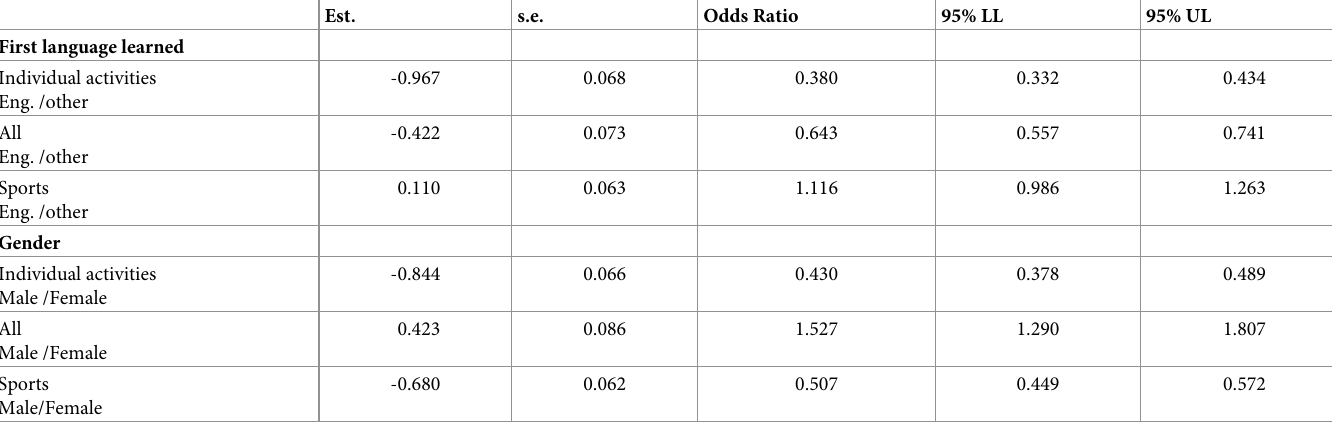
Table 3. Results of multinomial logistic regression analysis with demographics predicting latent class membership.